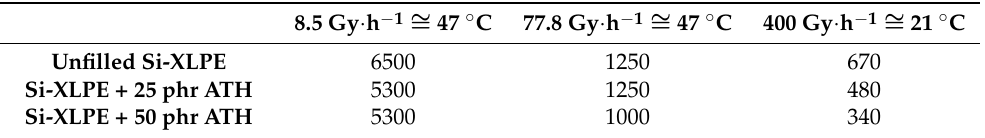
Table 6. Lifetime values (expressed in hours) graphically determined for the three materials under the three exposure conditions under study, as shown in Figure